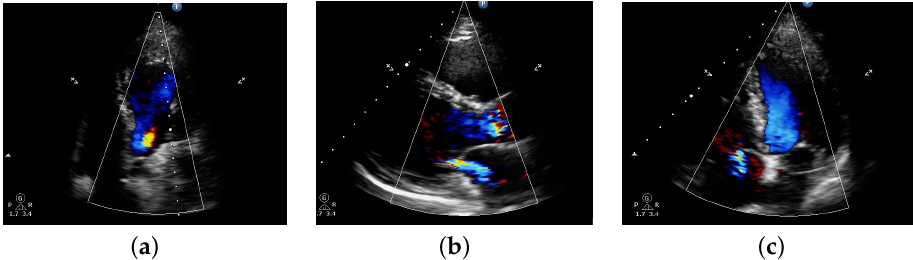
Figure 1. Diagram showing Doppler echo from dataset collected of patient having ( a ) Aortic Regurgita- tion (AR), ( b ) Mitral Regurgitation (MR), and ( c ) Tricuspid Regurgitation (TR) abnormalities